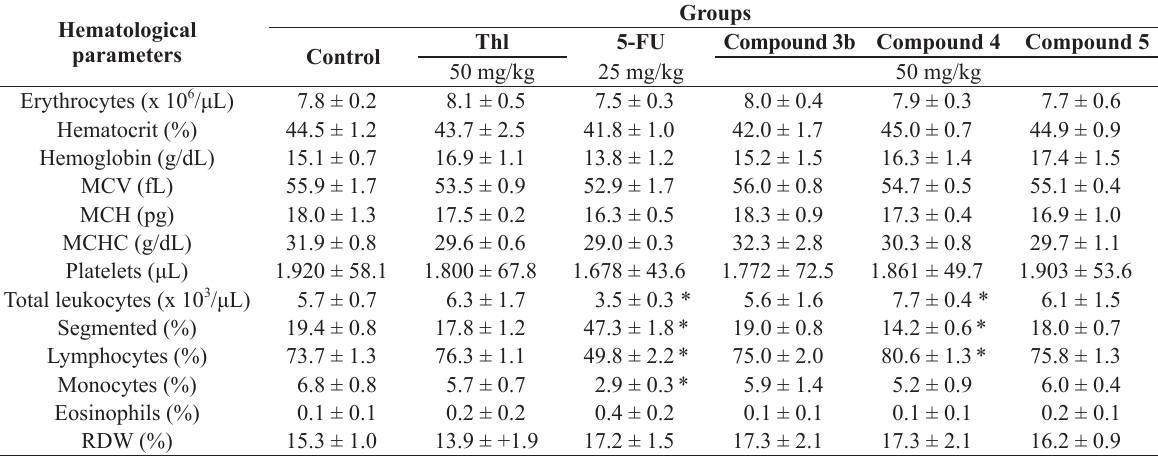
Effects of Thalidomide and N -phthaloyl amino acid derivatives on hematological parameters in peripheral blood of mice transplanted with Sarcoma 180 cells and treated during 7 days by intraperitoneal